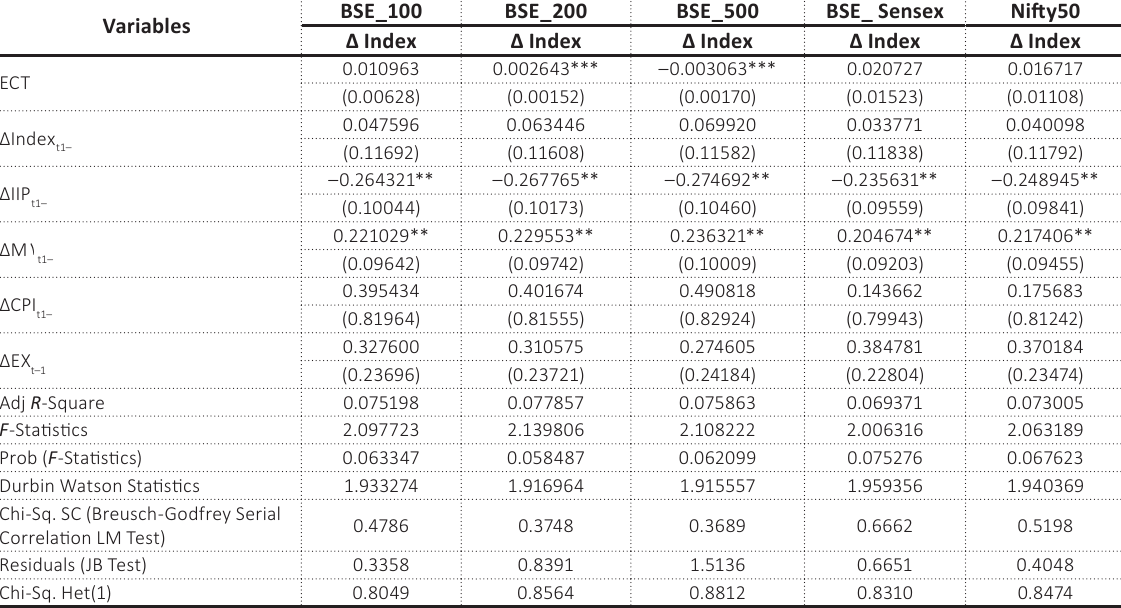
Table 6. Error correction